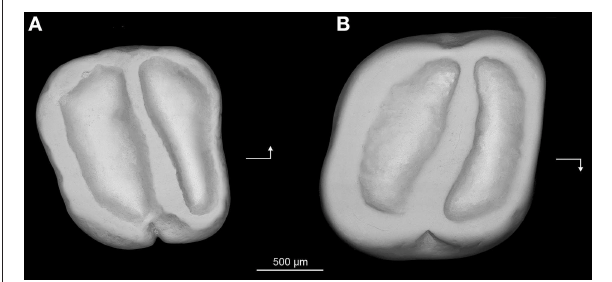
FIGURE 7 | Prozenkerella saharaensis , new genus and species, “Continental and Transitional Marine Deposits,” early Oligocene, Zallah Incision local fauna, central Libya. (A) holotype right lower molar (Z7I-12) in occlusal view; (B) referred right upper molar (Z7I-13) in occlusal view. Arrows point mesially and lingually to indicate